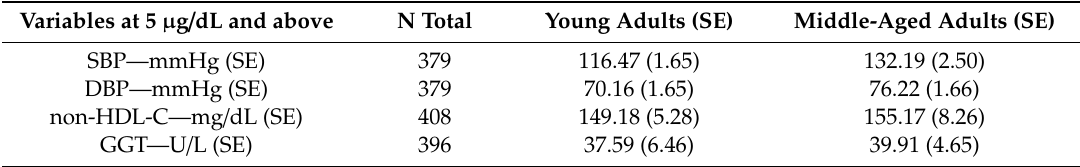
Table 2. How variables manifested at an exposure level of 5 µ g / dL and above among adults.